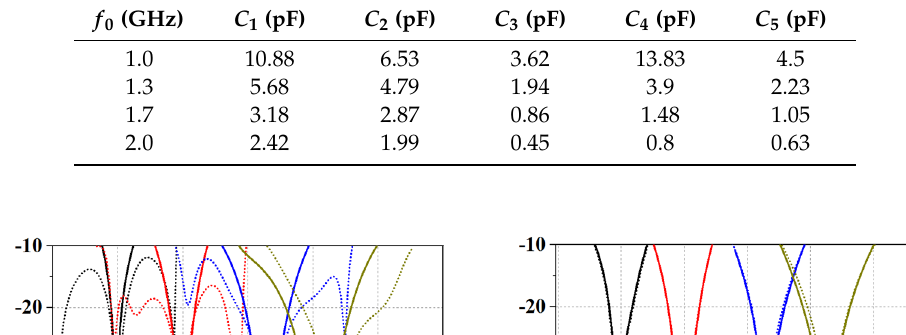
Figure 8. Curves of C 1 , C 2 , and C 3 versus the tuning frequency f 0